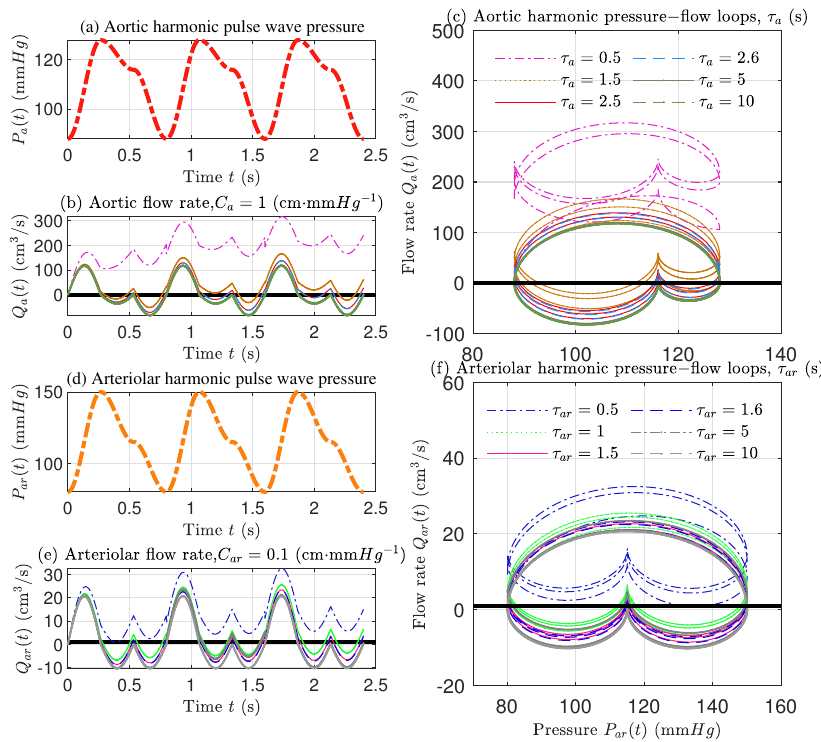
Figure 8. The responses of arterial blood flow modulated by GKF-QQ and BKF-NEF of ISFCM with harmonic blood-pressure pulsation input waves. ( a ) Aortic harmonic blood-pressure pulse wave input signal; ( b ) Blood-flow time-varying response of aorta modulated by GKF-QQ with different characteristic time τ a ; ( c ) The associated hysteresis loop of aortic blood flow and blood pressure with different τ a ; ( d ) Arteriolar harmonic blood-pressure pulse wave input signal; ( e ) Blood-flow time-varying response signal modulated by BKF-NEF of arteriole varying with different characteristic time τ ar ; ( f ) Associated hysteresis loops of arteriolar blood flow and blood pressure with different τ ar